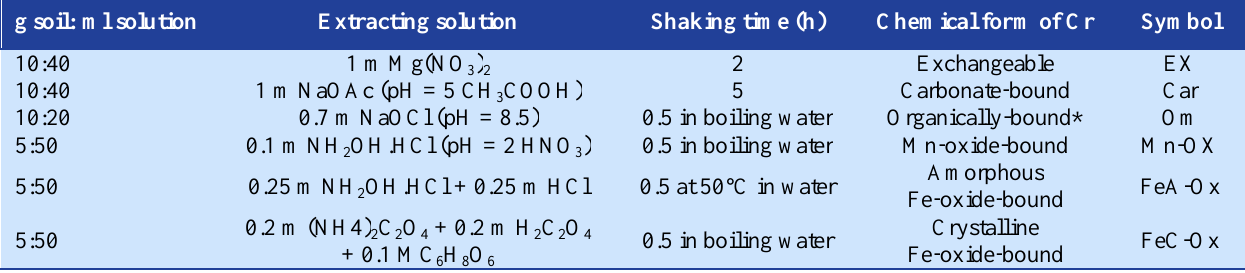
Table 4. Summary of the sequential extraction procedure used in this